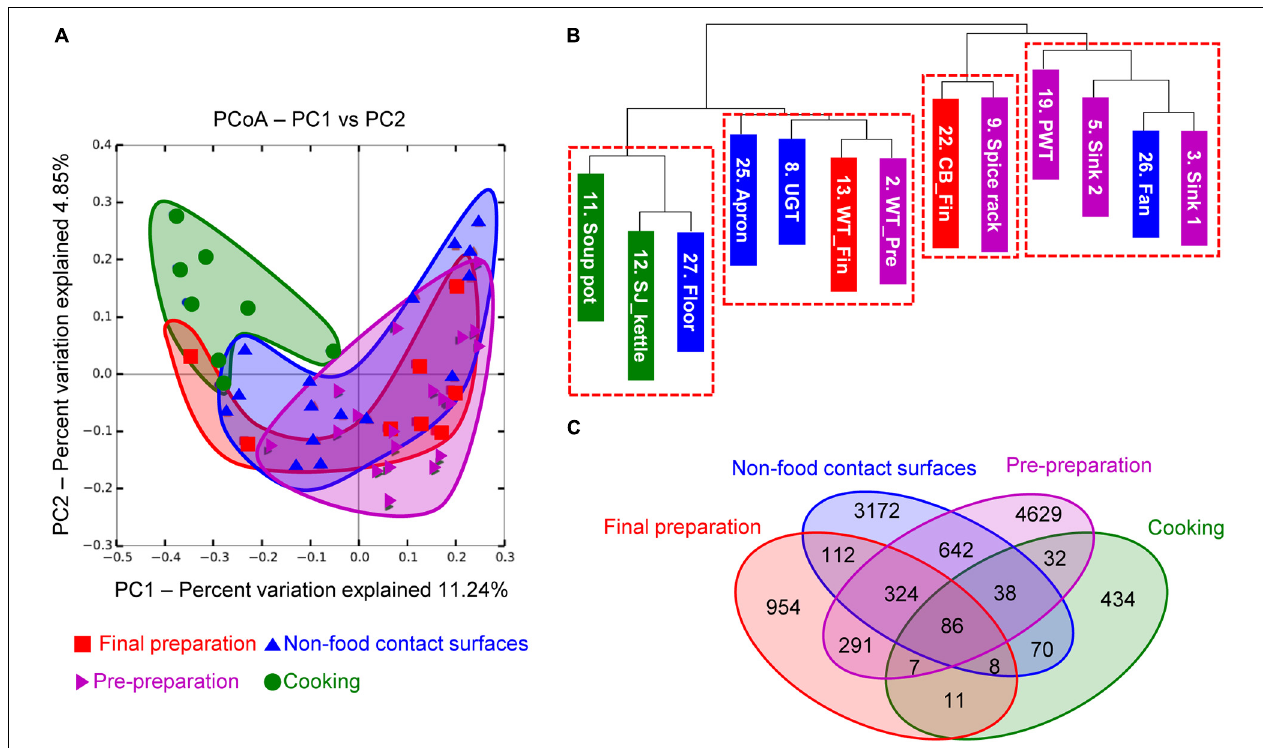
FIGURE 4 | Principal coordinate analysis (PCoA) based on unweighted UniFrac distances (A) , unweighted dendrogram (B) , and the distribution of shared OTUs (C) . Purple, green, red, and blue indicate location of each cooking process as pre-preparation area, cooking area, final preparation area, and cooking environment,